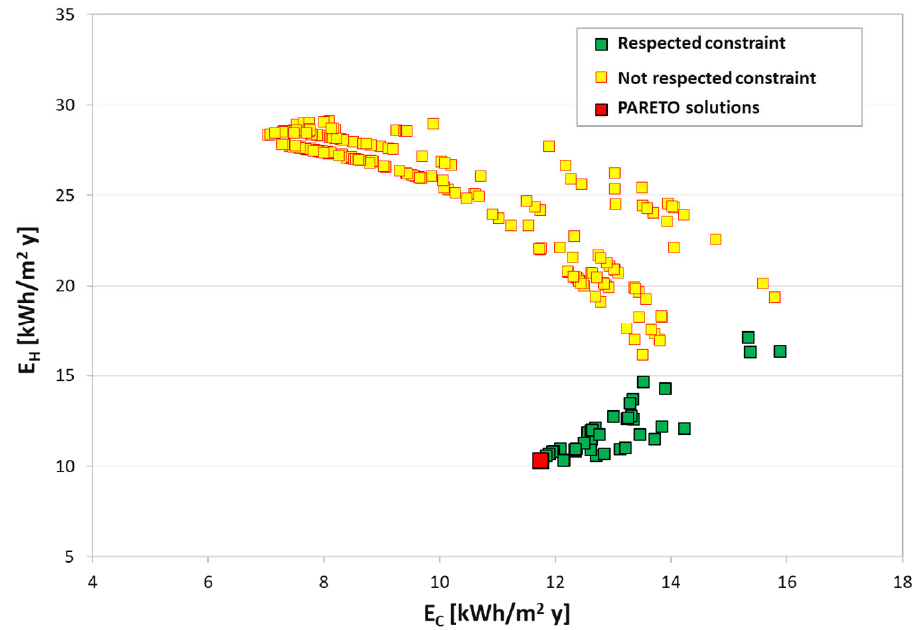
Figure 12. PCMs optimization: comparison based on heating and cooling load.